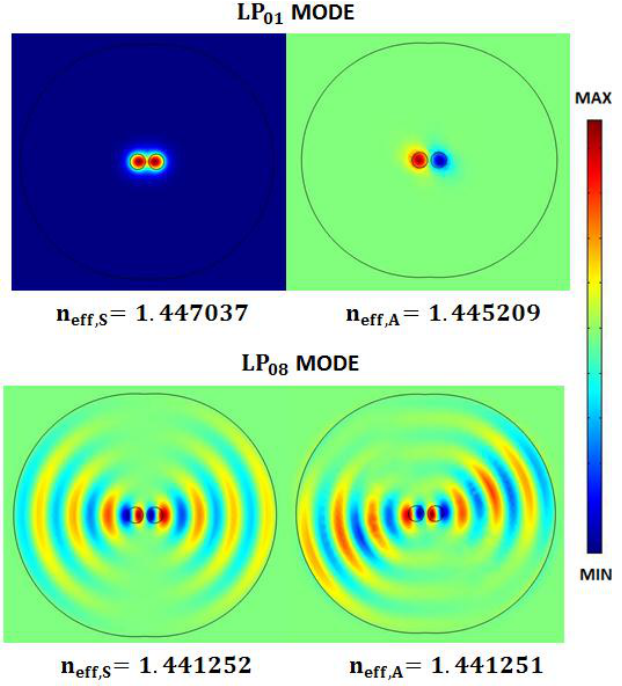
Figure 2. Symmetric and antisymmetric supermodes profiles and effective refractive indexes for LP 01 core mode and LP 08 cladding mode, respectively, simulated by FEM at 1550 nm considering two coupled fibers with core-to-core gap, DC gap , equal to 10 µm. The total transfer matrix is given by the product of the matrices corresponding to each section in